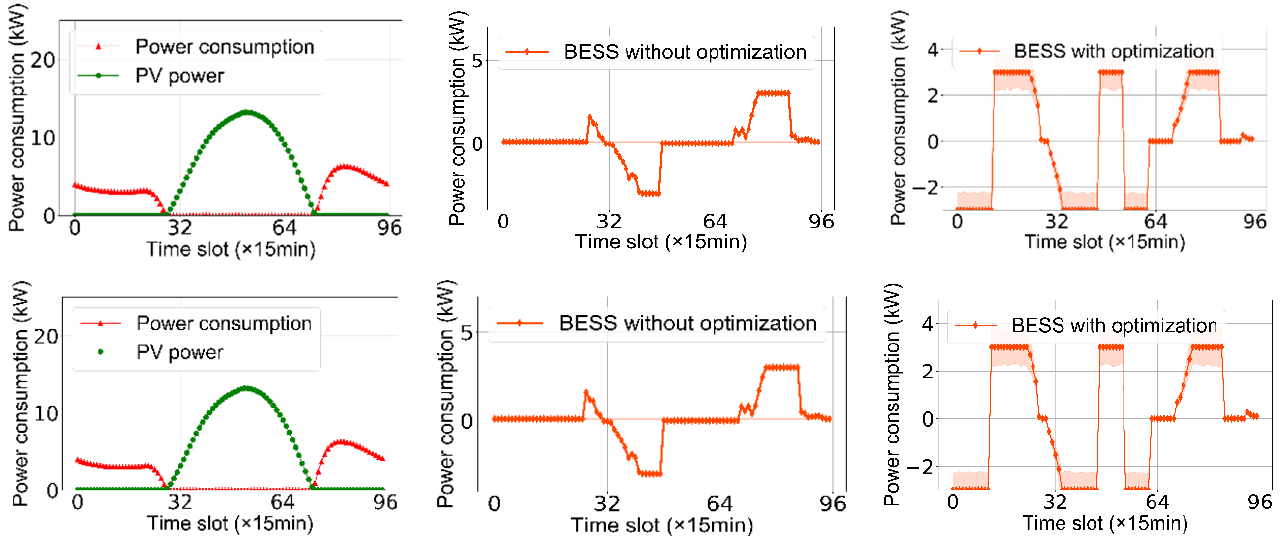
Figure 10. Power consumption, PV power, and BESS power of consumer III.